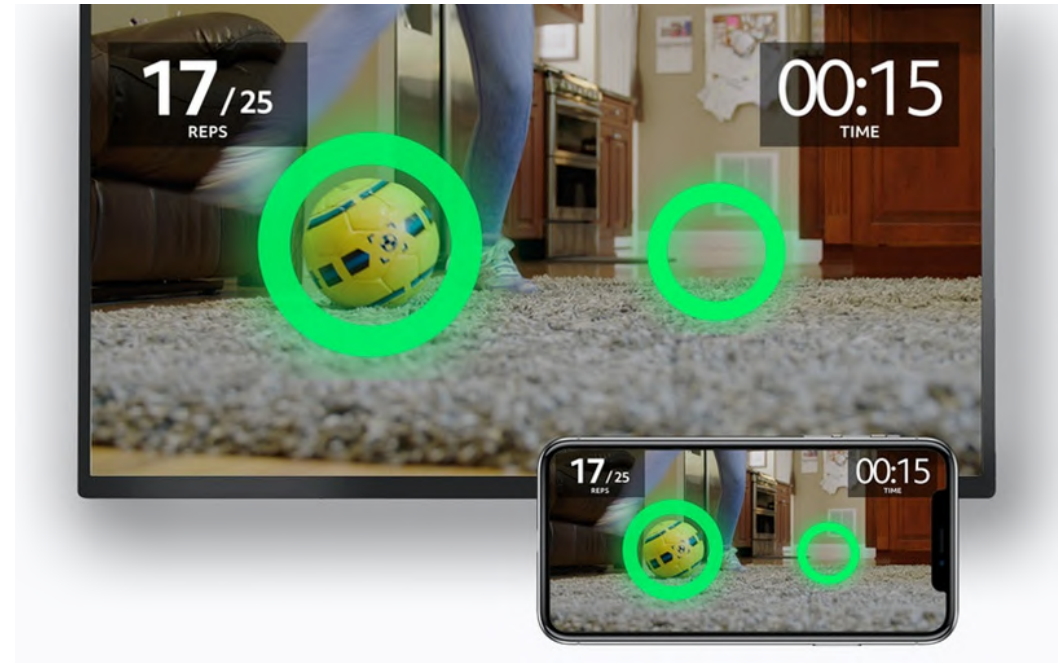
Figure 4: DribbleUp: Smart Soccer Ball